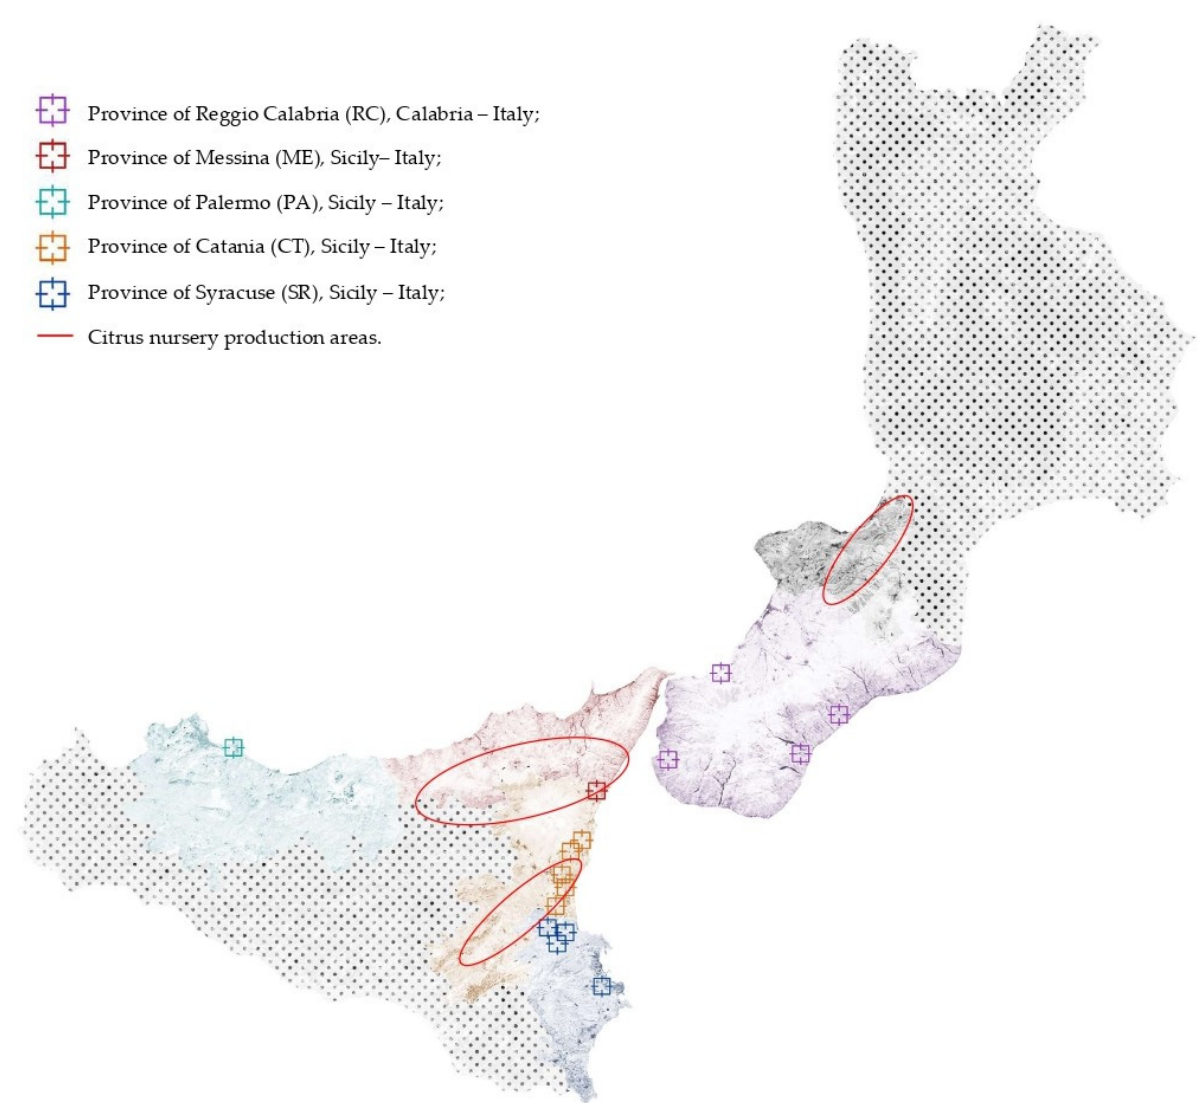
Figure 1. Map of southern Italy, including Sicily and Calabria, where sampling sites are indicated with colored squares (each color corresponds to a different province) while major citrus nursery production areas are indicated with circles. Table 1. Identity of the Neofusicoccum parvum isolates sourced from gummy cankers of lemon ( Citrus × limon ) trees in southern Italy characterized in this study, and corresponding GenBank accession numbers.